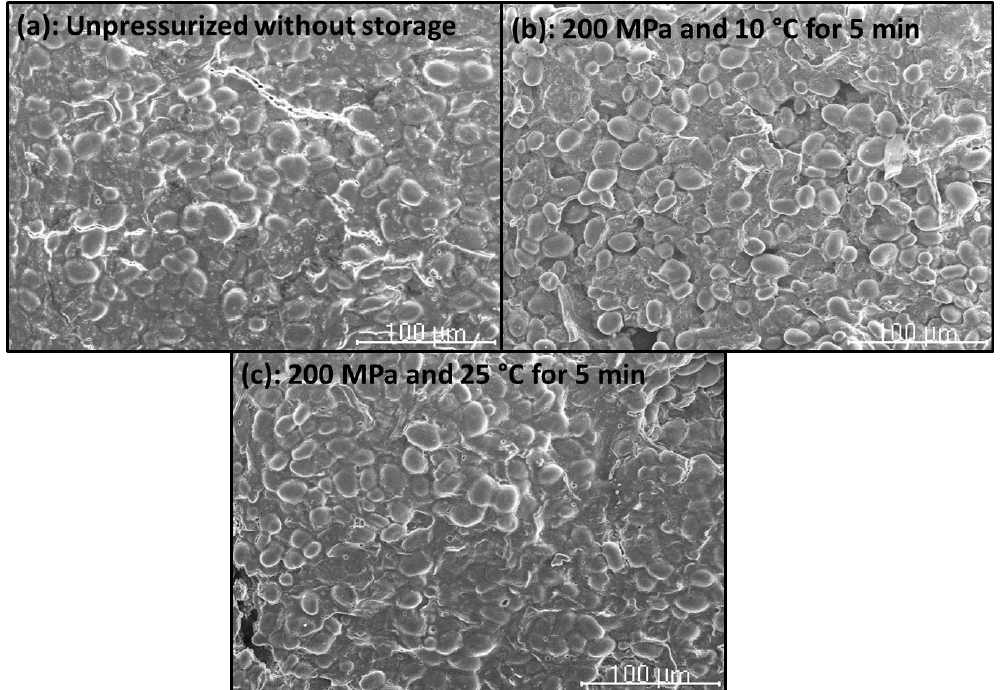
Figure 9. Scanning electron micrographs of unpressurized and pressurized CF in powder form at (300×) magnification: ( a ) Unpressurized CF without storage, ( b ) CF after pressurization at 200 MPa and 10 °C for 5 min, ( c ) CF after pressurization at 200 MPa and 25 °C for 5